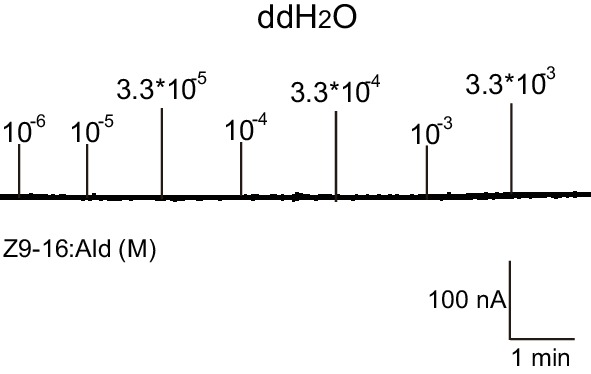
Two-electrode voltage-clamp recordings of Xenopus oocytes injected with distilled water and stimulated with pheromone compounds and analogs.No inward current responses of distilled-water-injected Xenopus oocytes to a range of Z9-16:Ald concentrations.